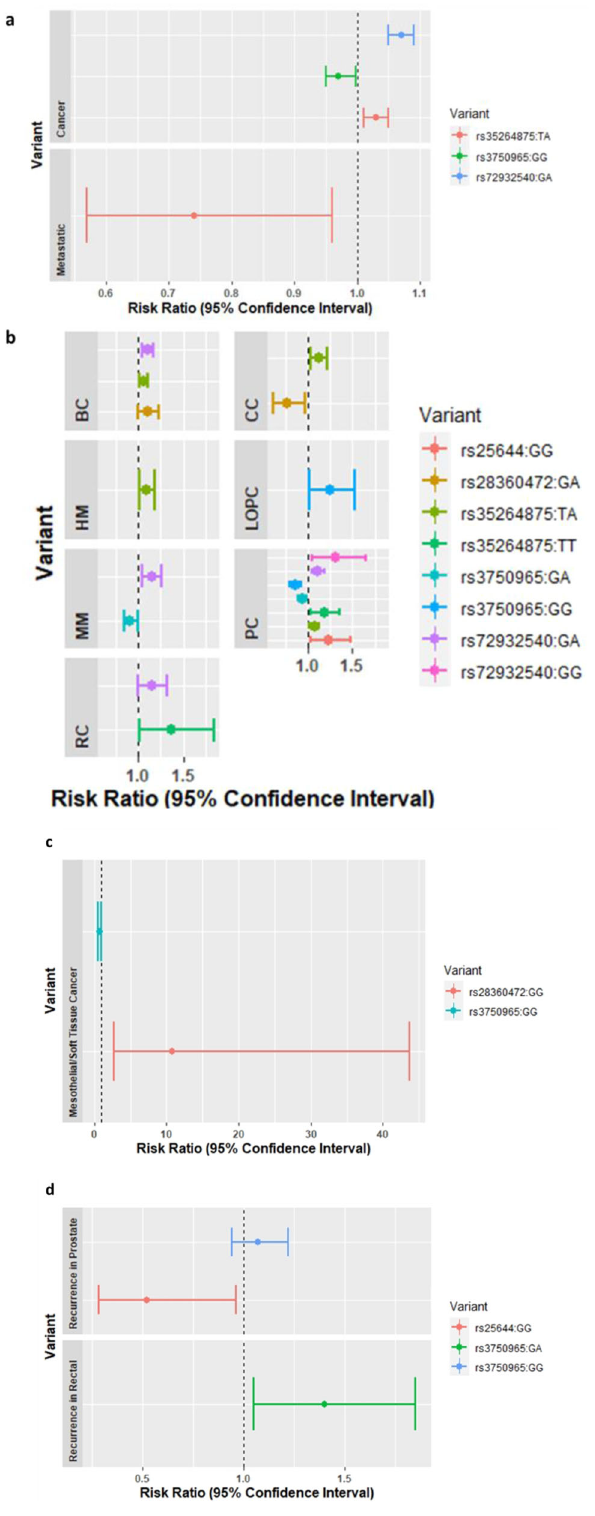
Fig. 2 Forrest plot showing genotypic ORs for signi fi cant SNPs in TPCN2/ P2RX4 . a – c Estimates were derived using logistic regression after adjusting for sex and ethnicity for cancer at a global level or various speci fi c types of cancer at a local level. d Estimates were derived using logistic regression after adjusting for age, sex, and ethnicity. BC breast cancer, HM malignant neoplasms, stated or presumed to be primary, of lymphoid, haematopoietic, and related tissue, MM malignant melanoma, PC malignant neoplasm of prostate, RC malignant neoplasm of rectum, LOPC malignant neoplasm of lip, oral cavity, and